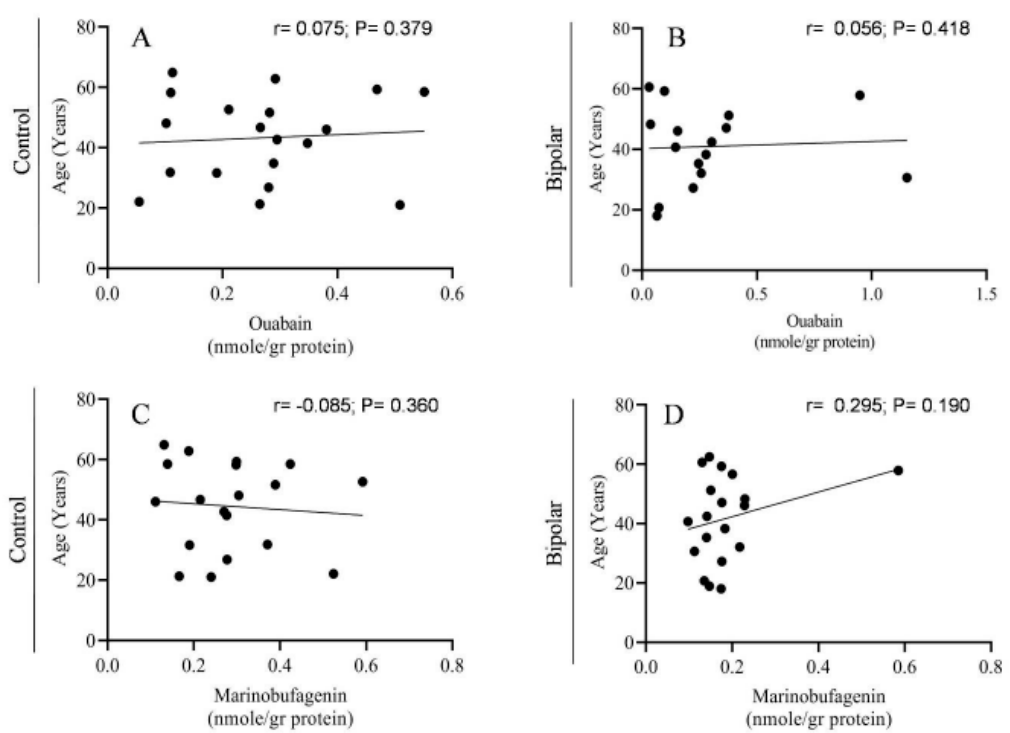
Figure 4. The correlation between endogenous OUA and MBG levels in the PFC with age. The OUA and MBG immuno-reactivity levels of PFC samples of controls ( A , C ) and BD patients ( B , D ) were correlated with age. Pearson ( r ) and p values (two tailed), depicted in the graphs, were calculated by using correlation analysis (GraphPad Prism v 8.3.1).